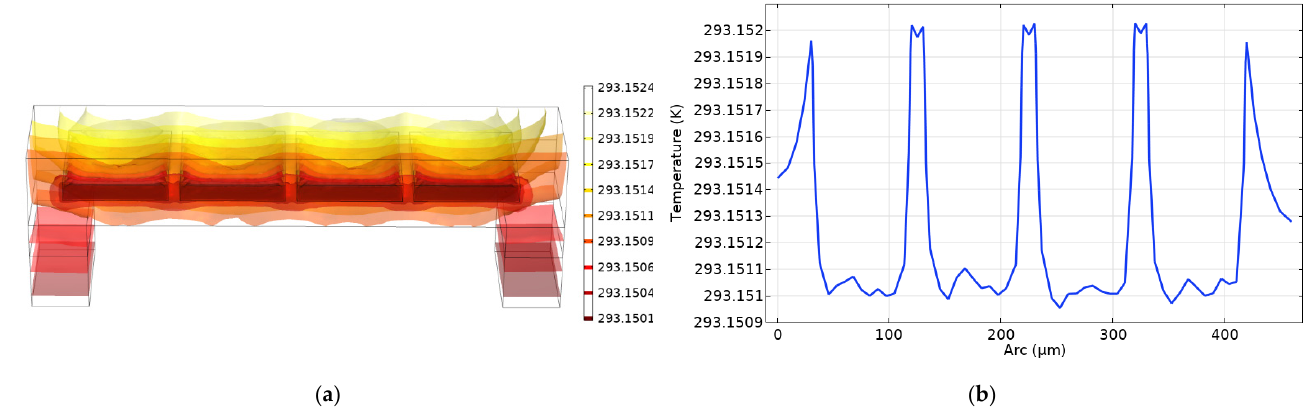
Figure 6. ( a ) Isothermal surface of a 100 μ m channel. ( b ) Temperature curve along the horizontal midline of the 100 μ m channel’s exit.